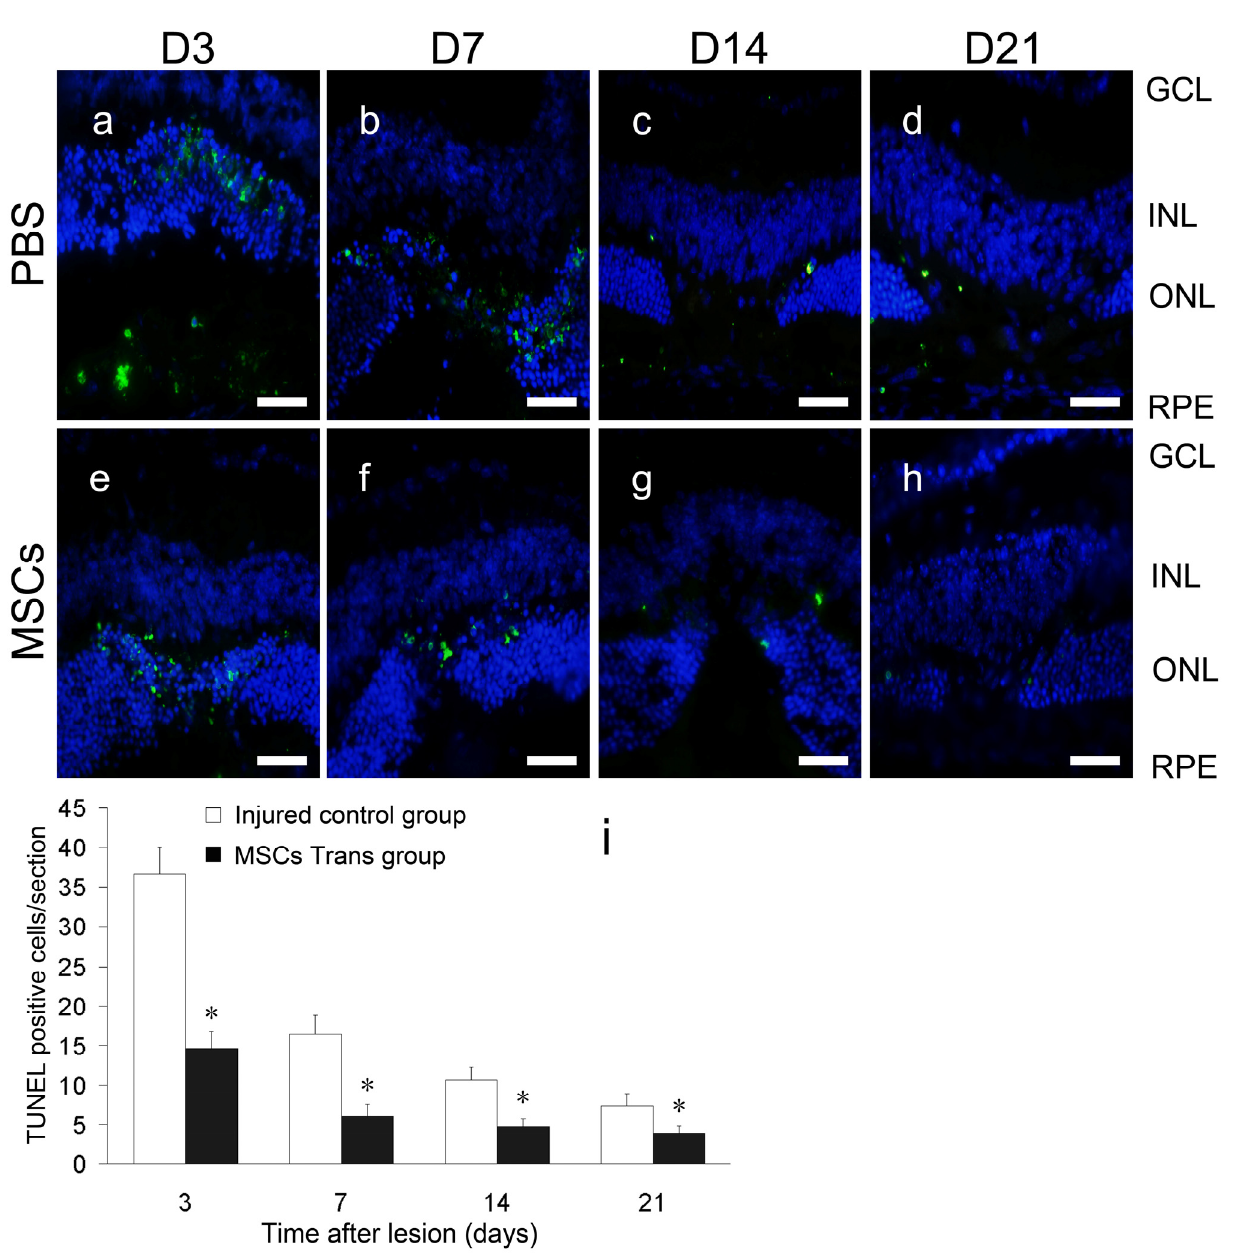
Figure 3. Apoptosis of retinal cells at laser spots in mice treated with or without MSCs. Retinas of the injured control group ( a – d ) and MSC-treated group ( e – h ). Green indicates terminal deoxynucleotidyl transferase-mediated dUTP-biotin nick-end labeling (TUNEL)+ cells. Blue indicates DAPI-stained nuclei. Scale bars: 50 μ m. The average numbers of apoptotic cells were calculated and found to be significantly reduced in the MSC-treated group at all time points compared with those in the injured control group ( i ). *, p < 0.05. Scale bars: 50 µm. GCL, ganglion cell layer; INL, inner nuclear